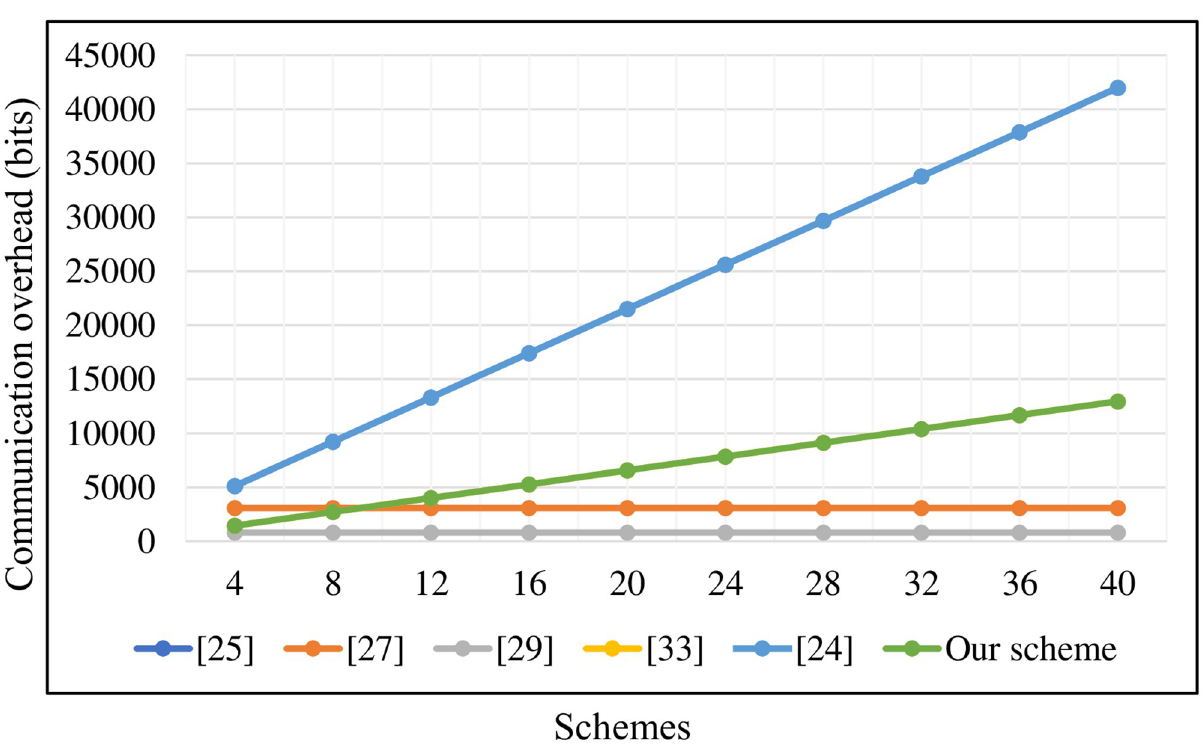
Fig 5. Communication overhead of aggregate